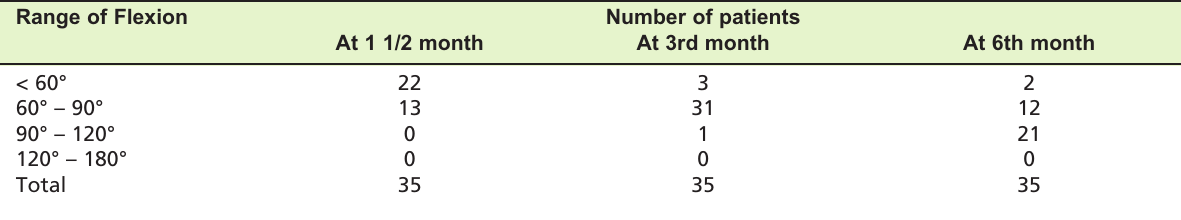
Number of patients in defined flexion range at each follow-up visit Table I: